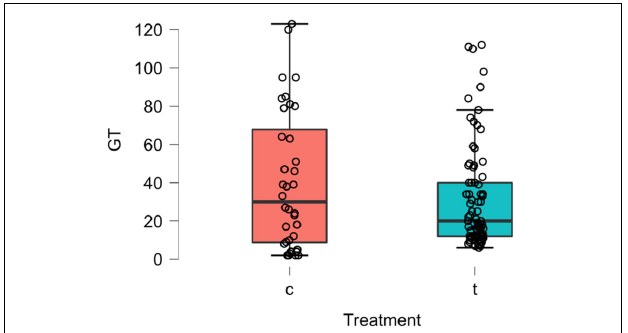
FIGURE 5 | Results of the primary study involving Western Diamond-backed Rattlesnakes ( C. atrox ). Box plots of mean germination times (GT - days) of P . microphylla seeds for control (c) and treatment (t) groups for 128 days. Horizontal line in boxes = median. Mann-Whitney U test: U = 1465.5, P = 0.626, ns.